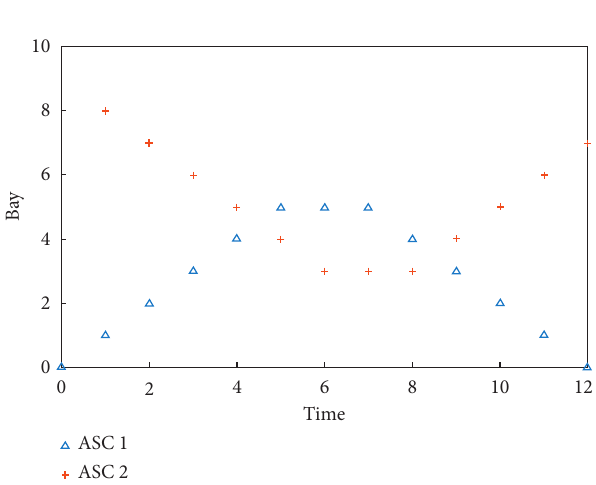
Figure 4: Movement graph for nondelay schedule of twin